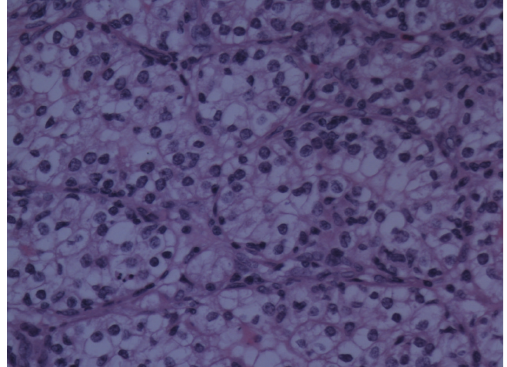
Figure 4: Metastatic renal cell carcinoma in the